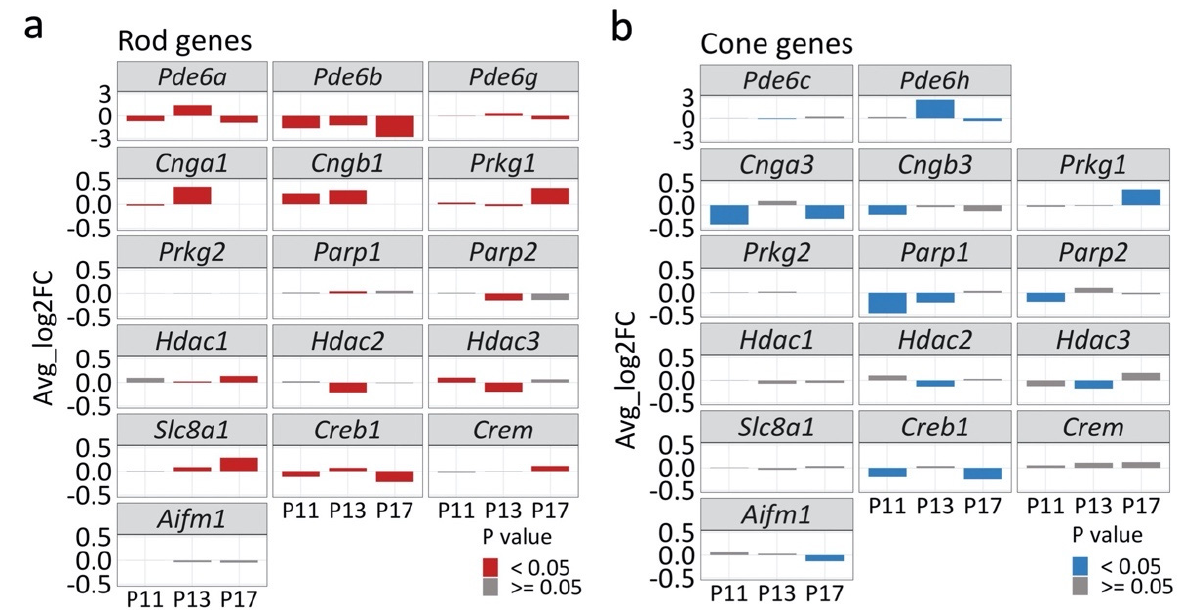
Figure 5. Expression of genes related to cell death in rods ( a ) and cones ( b ). Bar plots showing transcriptomic changes in genes coding for phosphodiesterase 6 (PDE6; i.e., Pde6a , Pde6b , Pde6c , Pde6g , Pde6h ), cyclic-nucleotide-gated channels (CNG channels; i.e., Cnga1 , Cngb1 , Cnga3 , Cngb3 ), protein kinase G (PKG; Prkg1 , Prkg2 ), poly(ADP − ribose) polymerase (PARP; Parp1 , Parp2 ), histone deacetylase (HDAC; Hdac1 , Hdac2 , Hdac3 ), Na + /Ca 2+ exchanger 1 (NCX1; Slc8a1 ), cAMP response element-binding protein 1 ( Creb1 ) and cAMP response element modulator ( Crem ), and apoptosis inducing factor 1 ( Aifm1 ). The x − axis indicates postnatal day (P), and y − axis depicts average log 2 fold change; positive values indicating higher expression in rd1 rods/cones. Bars were color − coded (red for rods; blue for cones) for p − values < 0.05.